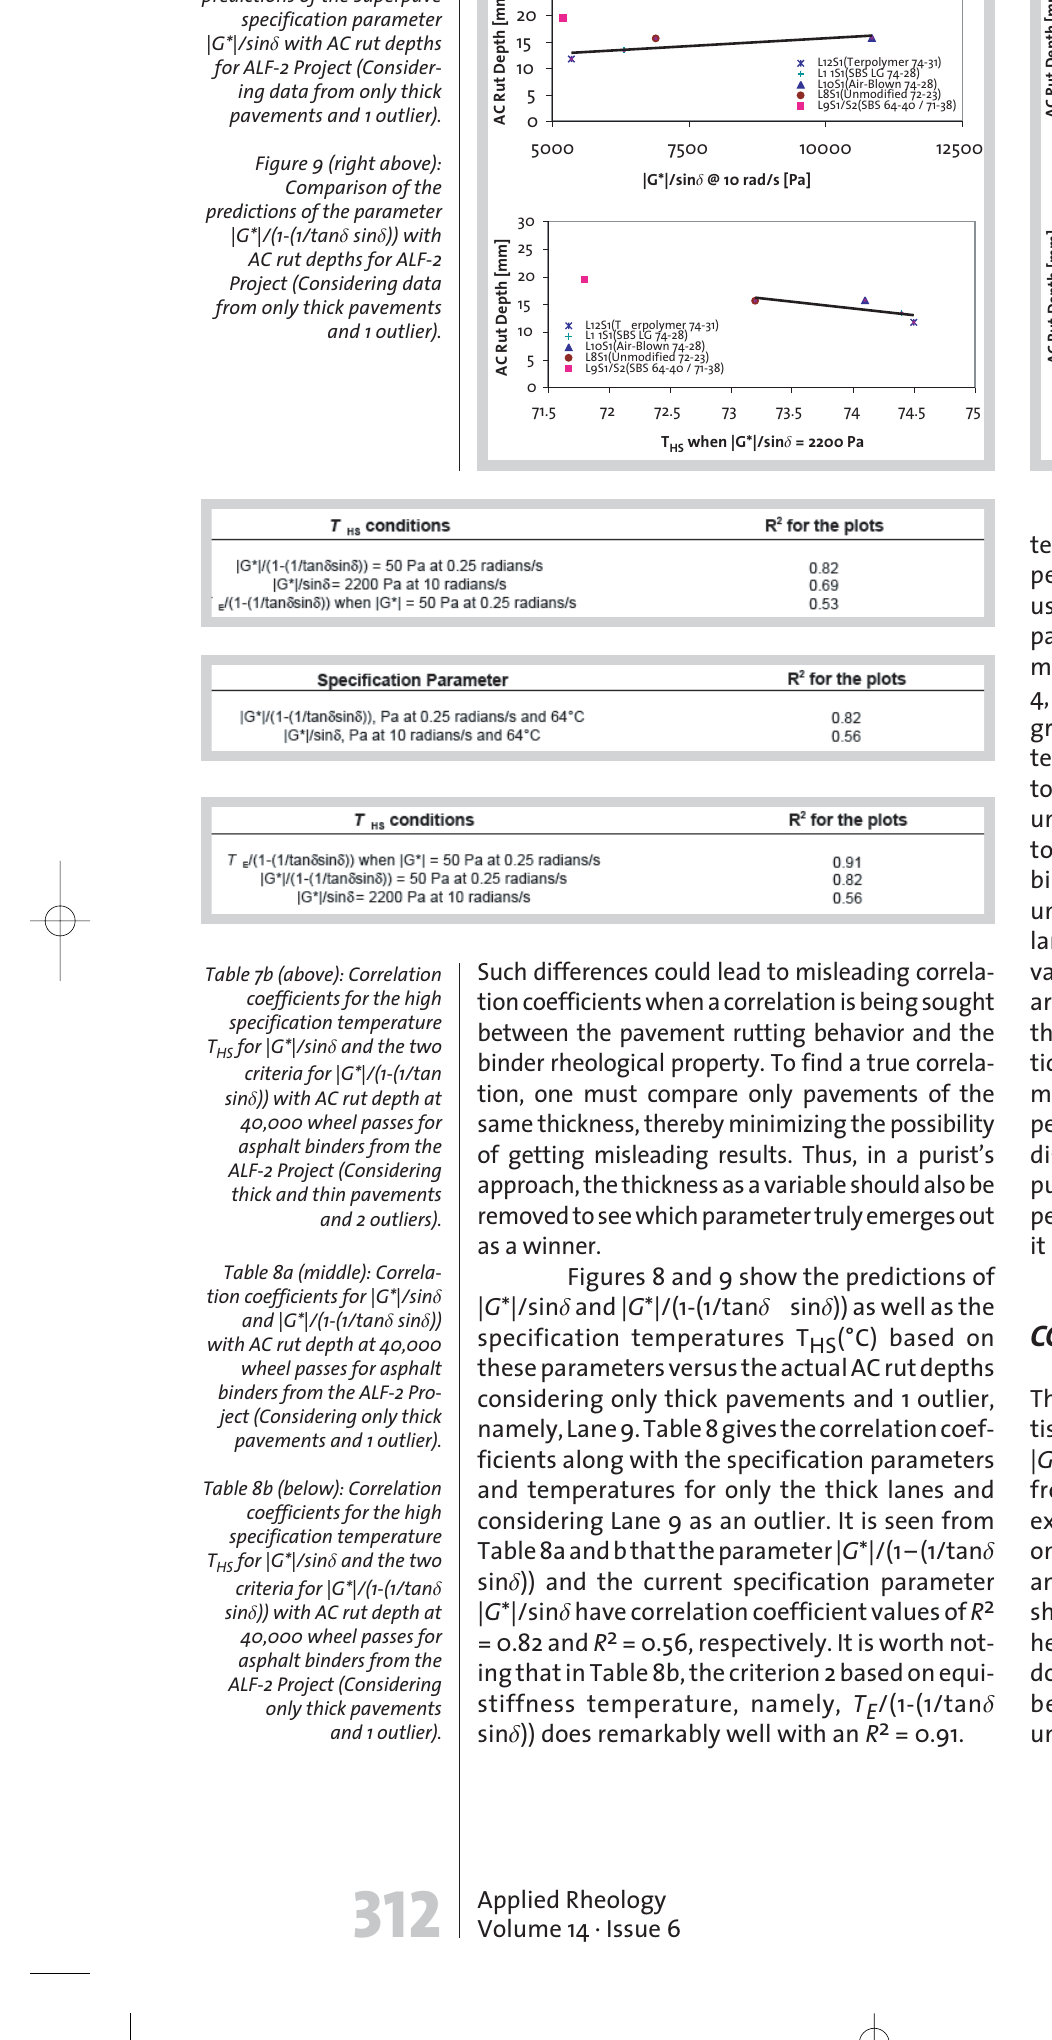
Figure 8 (left above): Comparison of the predictions of the Superpave specification parameter |G*|/sin d with AC rut depths for ALF-2 Project (Consider- ing data from only thick pavements and 1 outlier). Figure 9 (right above): Comparison of the predictions of the parameter |G*|/(1-(1/tan d sin d )) with AC rut depths for ALF-2 Project (Considering data from only thick pavements and 1 outlier).